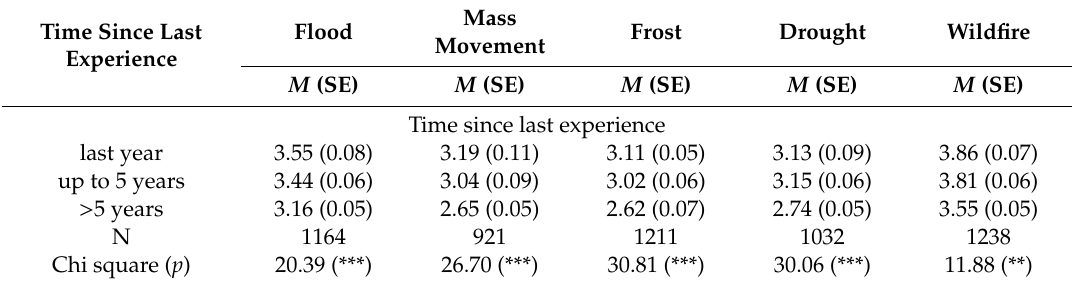
Table 6. E ff ect of the time since last disaster experience on risk perception for each natural hazard. Time Since Last